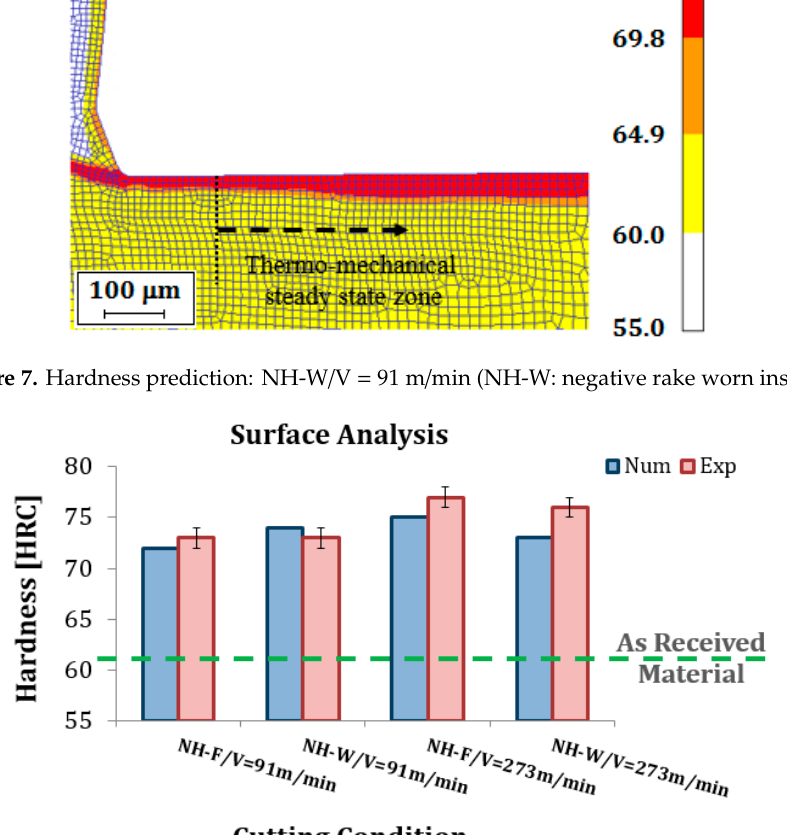
Figure 7. Hardness prediction: NH-W/V = 91 m/min (NH-W: negative rake worn insert).